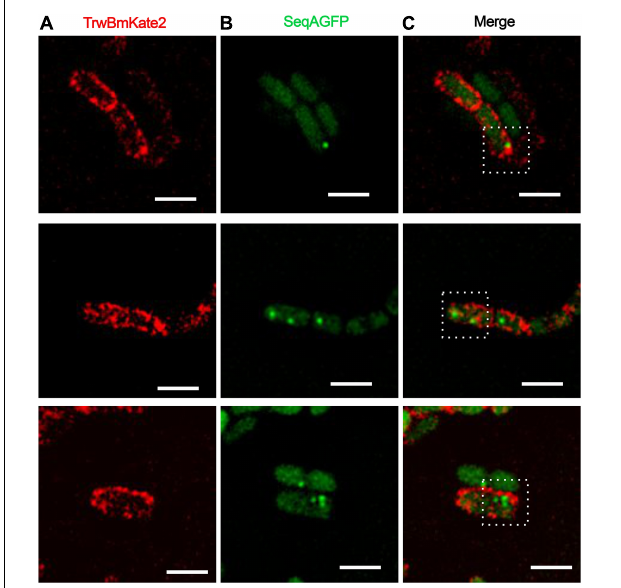
FIGURE 5 | Conjugative R388 transfer visualized as fluorescent SeqA-GFP foci in recipient cells. MG1655 dam + donor cells hosting R388: trwBmKate2 were mated with dam - recipient cells expressing SeqA-GFP from the chromosome. Conjugation was performed in enriched M9 minimal media plates and then, cells were transferred to the microscope for image-recording. Transconjugants were monitored by the presence of fluorescent foci, indicating the binding of SeqA-GFP to hemy-methylated DNA. In some transconjugant cells, up to three independent foci were detected. Images show the same pad of transconjugant cells recorded at different emission wavelengths: 630 nm for mKate2 ( A , red) and 540 nm for SeqA-GFP ( B , green). The merged images in panel (C) show the fluorescent foci of SeqA-GFP plus TrwBmKate2 in the membrane, which is expressed from the recently transferred R388 plasmid. (Scale bar: 2 µ